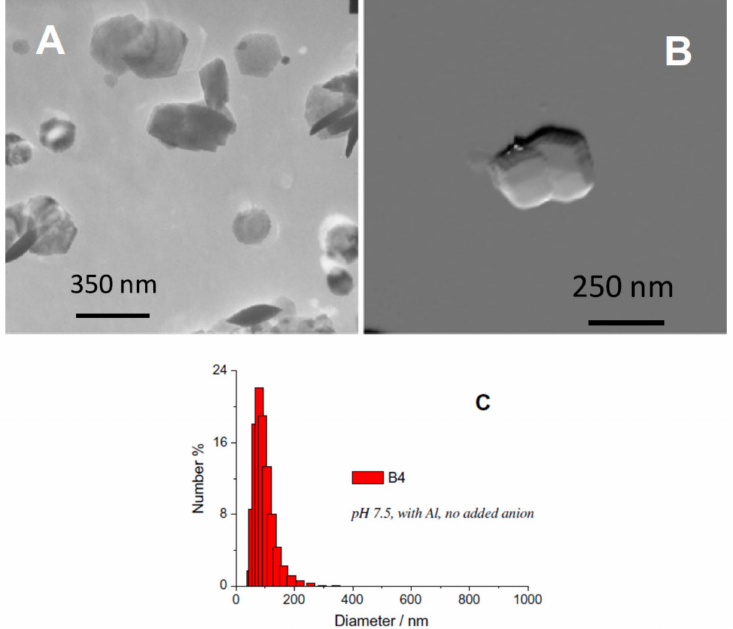
Figure 7. ( A , B ) TEM and AFM images of typical rhombohedral shape of α -Fe 2 O 3 nanoparticles, respectively; ( C ) size distribution obtained by dynamic light scattering(DLS). Obtained permission from Ref. [60]. Copyright 2012